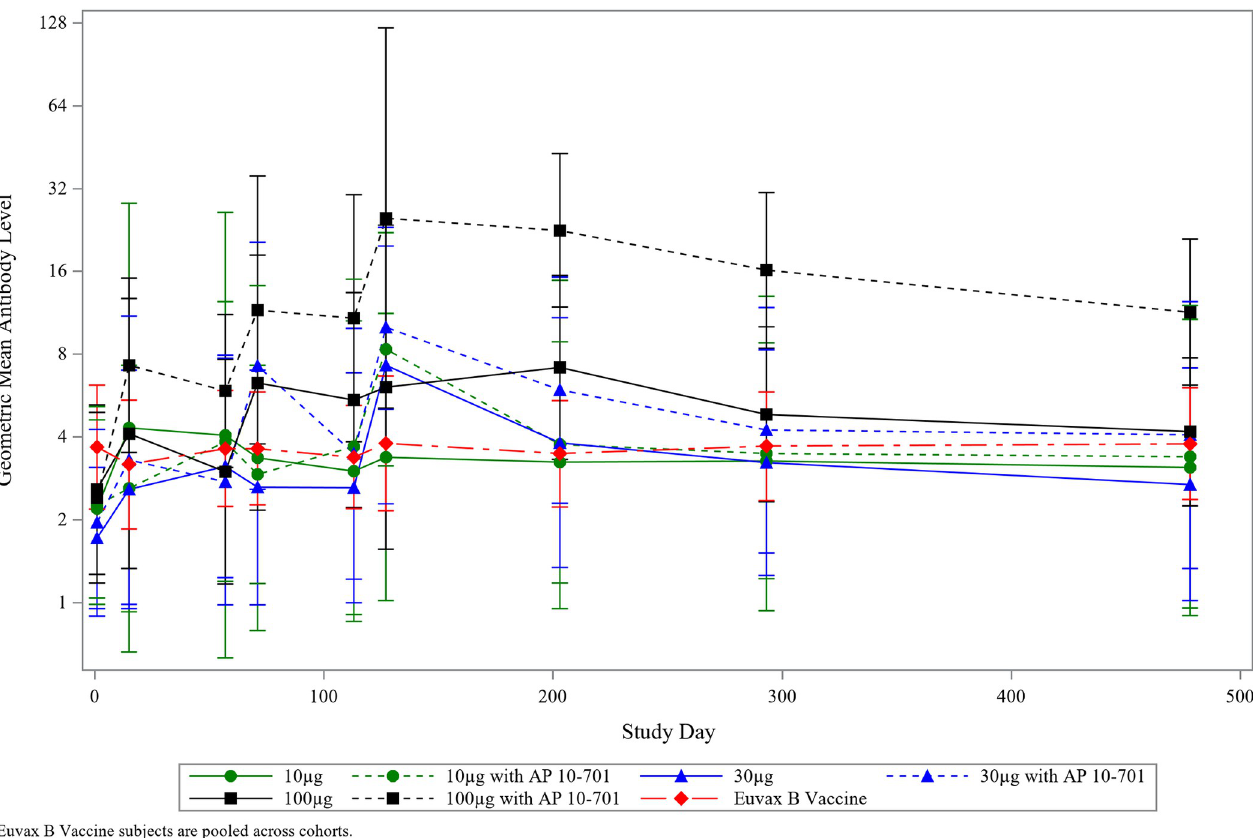
Fig 4. Geometric mean anti- Sm -TSP-2 IgG levels over time by vaccine group, as measured by ELISA (Arbitrary Units). Per-protocol immunogenicity population. Vaccinations were administered on study days 1, 57, and 113. Error bars represent 95% confidence intervals. Euvax B hepatitis B recipients were pooled across